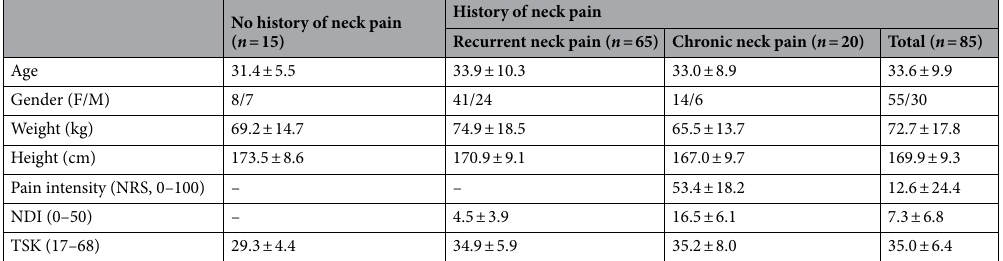
Table 2. Demographic characteristics (mean ± SD). NDI Neck disability index, TSK Tampa scale for